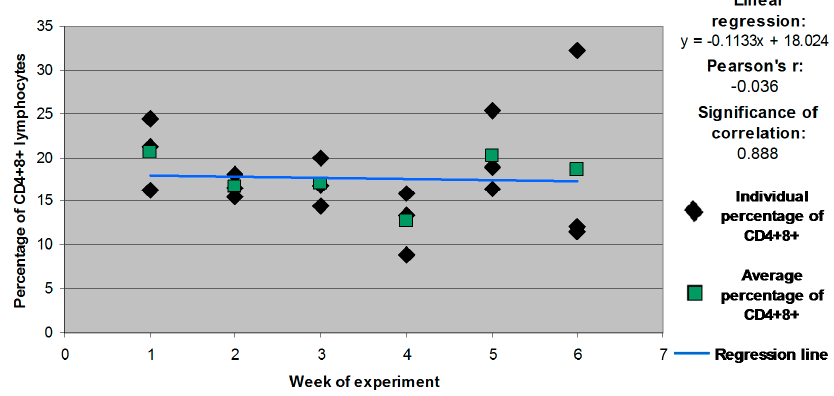
Figure 3. Individual and mean percentages of CD4 + 8 + lymphocyte subpopulations in group E1.